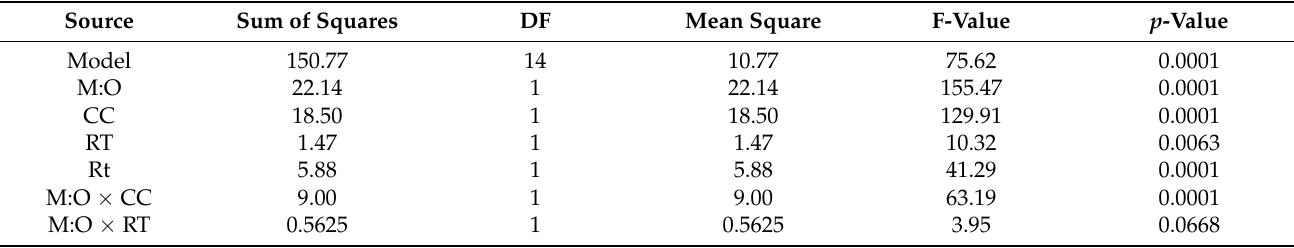
Table 5. Analysis of variance for biodiesel